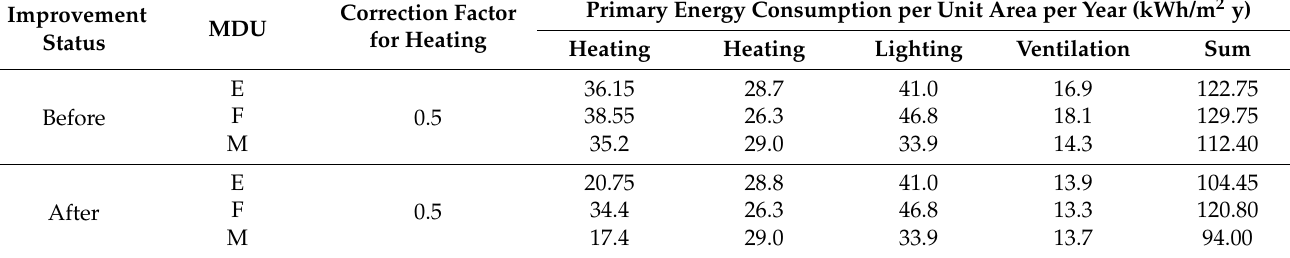
Table 9. Results of applying the heating energy correction factor suggested in ‘Comparison of heating energy consumption and actual consumption of MDU by the Building Energy Efficiency Rating Program’ (application of the correction factor for the central region).